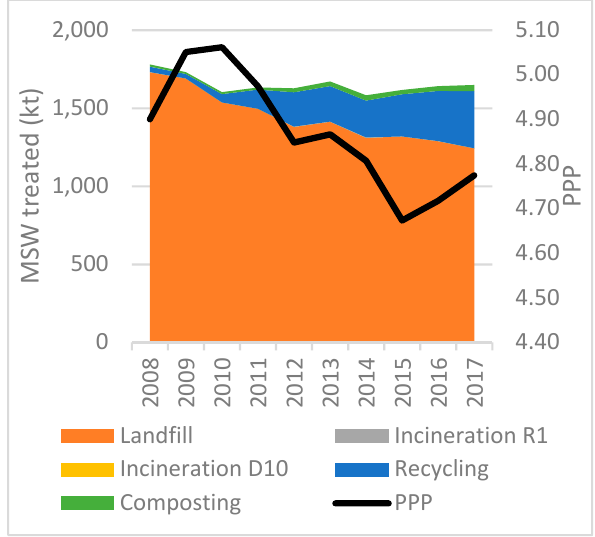
Figure 22. Waste treatment methods and PPP in Croatia 2008–2017 (EUROSTAT 2019b, 2019c).